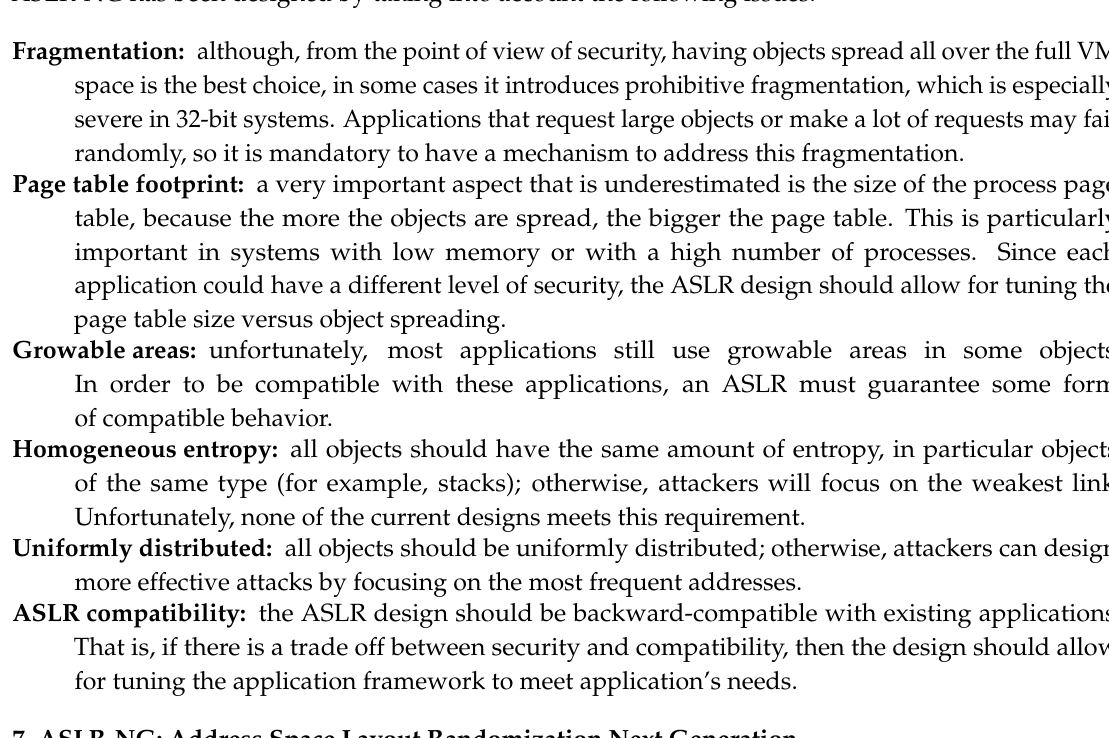
Page table footprint: a very important aspect that is underestimated is the size of the process page table, because the more the objects are spread, the bigger the page table. This is particularly important in systems with low memory or with a high number of processes. Since each application could have a different level of security, the ASLR design should allow for tuning the page table size versus object